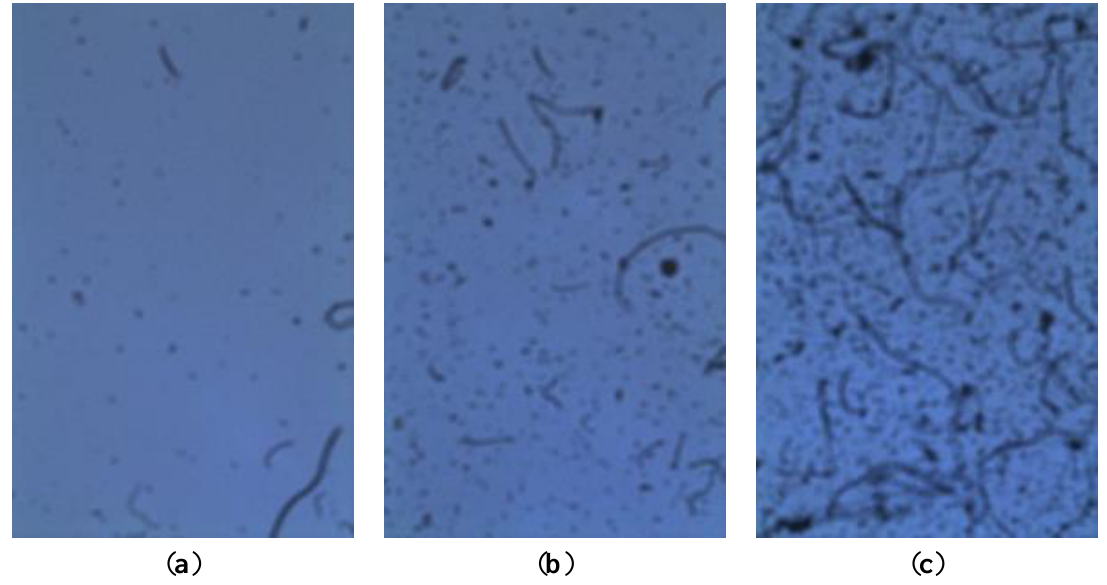
Figure 9. Some images acquired at different